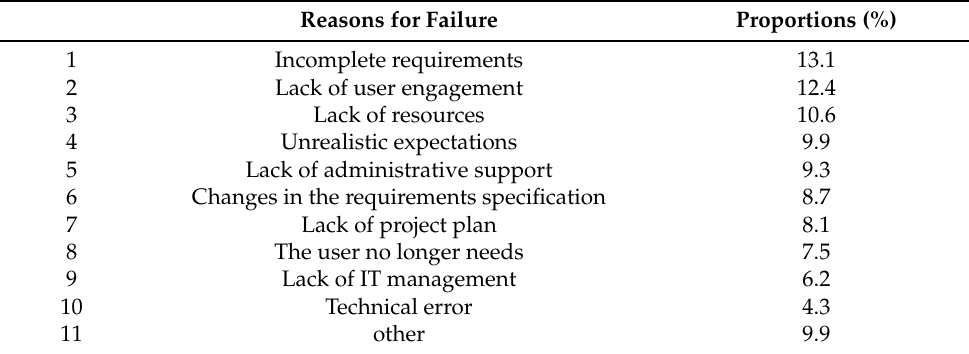
Table 1. Factors that cause software projects to